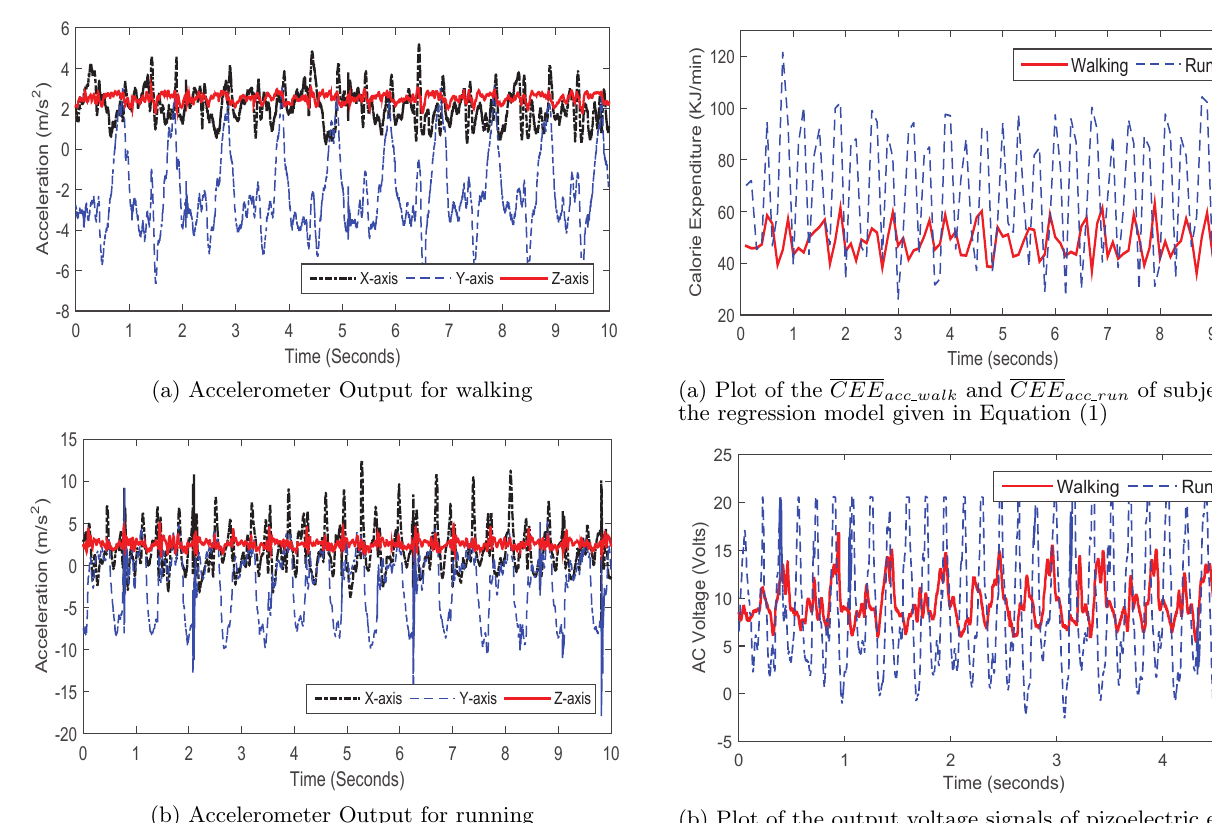
(b) Plot of the output voltage signals of pizoelectric energy har- vester Figure 6: Plot of the output voltage and calorie ex- penditure for subject 2. Walking Running